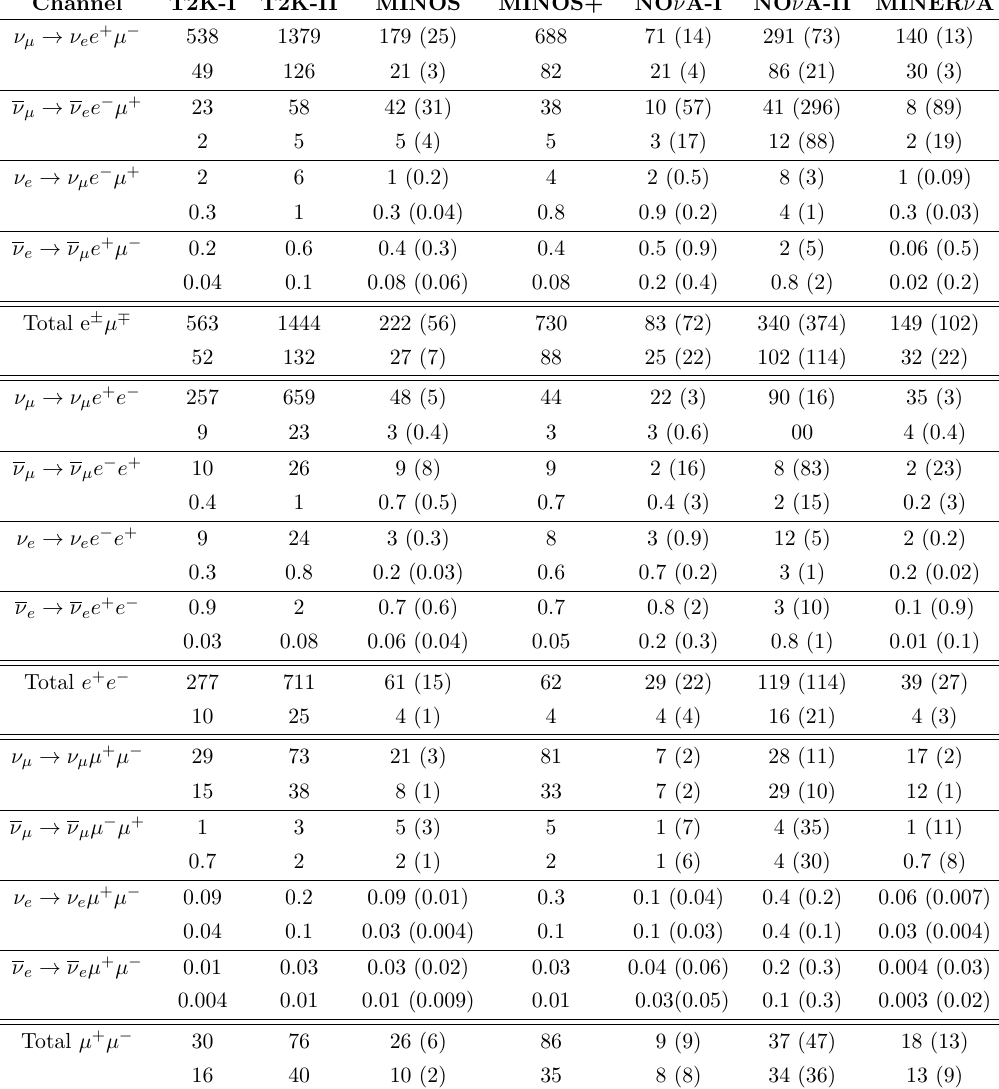
Table 7 . Total number of coherent (top row) and di(cid:11)ractive (bottom row) trident events expected at di(cid:11)erent non-LAr detectors for each channel. The numbers in parentheses are for the antineutrino running mode, when present. These calculations consider a detection e(cid:14)ciency of